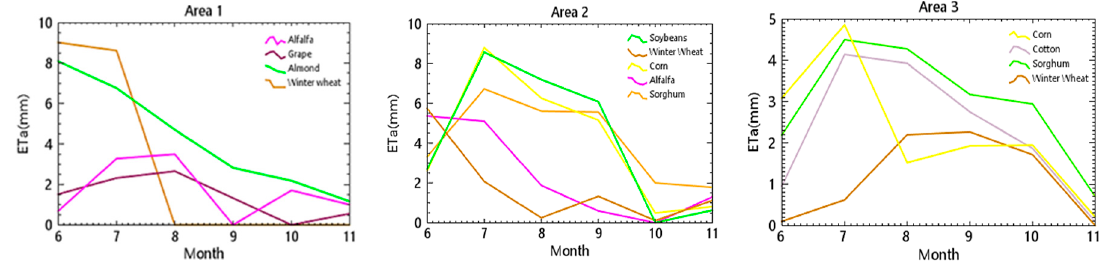
Figure 9. Mean curves of the actual evapotranspiration (ETa) for each crop.